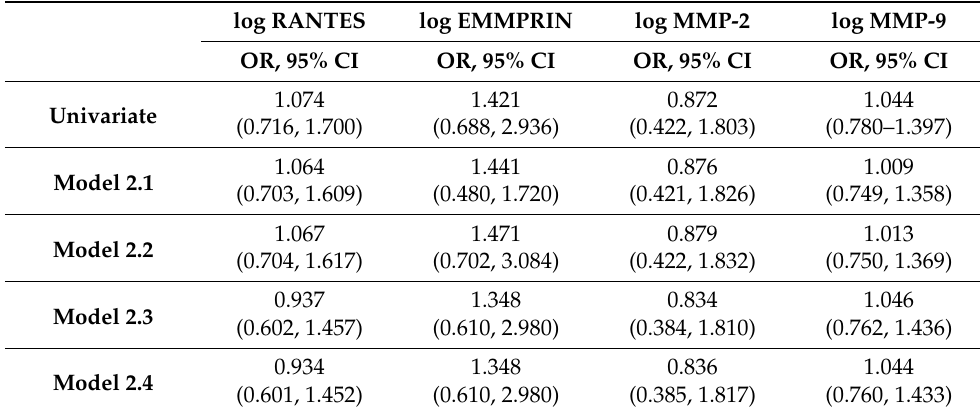
Table 3. Association of inflammatory biomarkers with